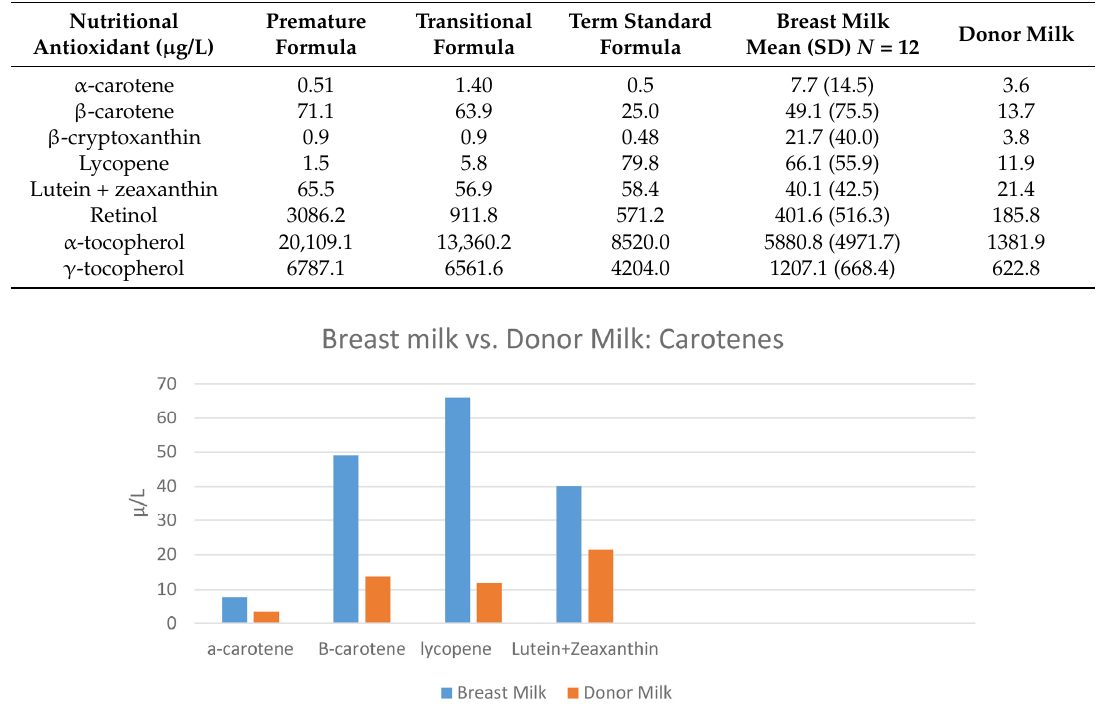
Figure 1. The concentrations of α -carotene, β -carotene, lycopene, and lutein + zeaxanthin in maternal breast milk vs. donor milk samples. Lycopene was statistically significant ( p = 0.006). Samples of the transitional formula and premature formula were also significantly lower in lycopene when compared to breast milk ( p = 0.003 and 0.002, respectively) (see Table 1). When concentrations of tocopherols between the 12 breast milk samples and the pooled donor milk sample were compared, a statistically significant difference was found between concentrations of both α‐ and γ‐ tocopherols ( p = 0.009 and 0.01, respectively). A comparison of concentrations of tocopherols in breast milk vs. donor milk is shown in Figure 2.